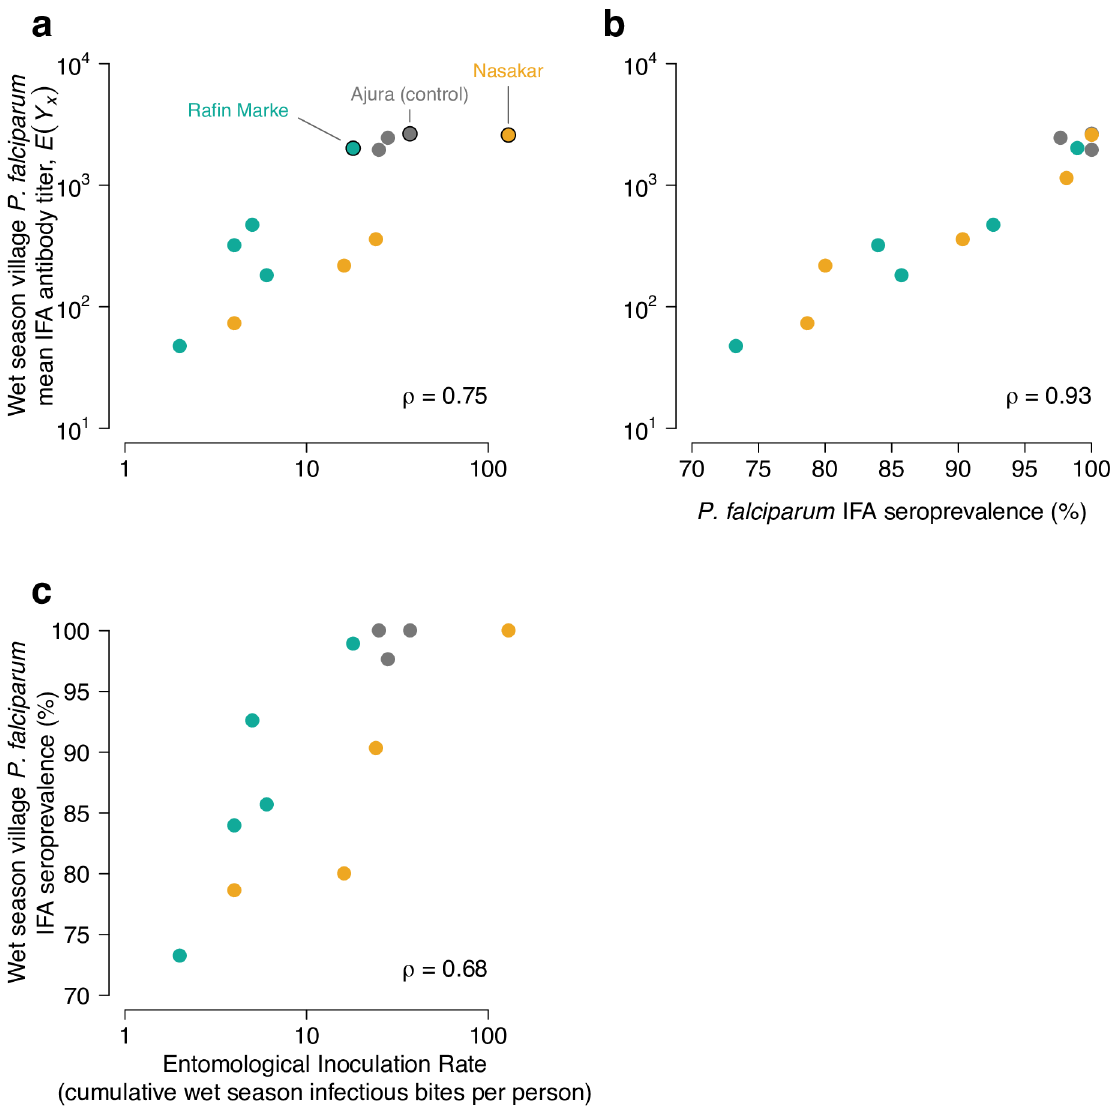
Fig 3. Comparison of mean Plasmodium falciparum IFA antibody titers with wet season entomological inoculation rate (EIR) and IFA seroprevalence in the three study villages with paired entomological and serological measurements. a, P . falciparum IFA titers versus EIR. b P . falciparum IFA titers versus seroprevalence. c, P . falciparum seroprevalenceversus EIR. Ajura was a control village(no treatment) whileRafine Marke and Nasakar were intervention villages.A singledata point outside the figure range is not shown in EIR plots (Nasakar 1972, EIR value = 0, E ( Y x ) = 103.0591),but was includedin the Spearman’s rank correlation estimates ( ρ ). The source data used to generatethis figure are here: https://osf.io/8tqu4 (garki), and the scripts used to generatethe figure are here: https://osf.io/ek3sx (garki).